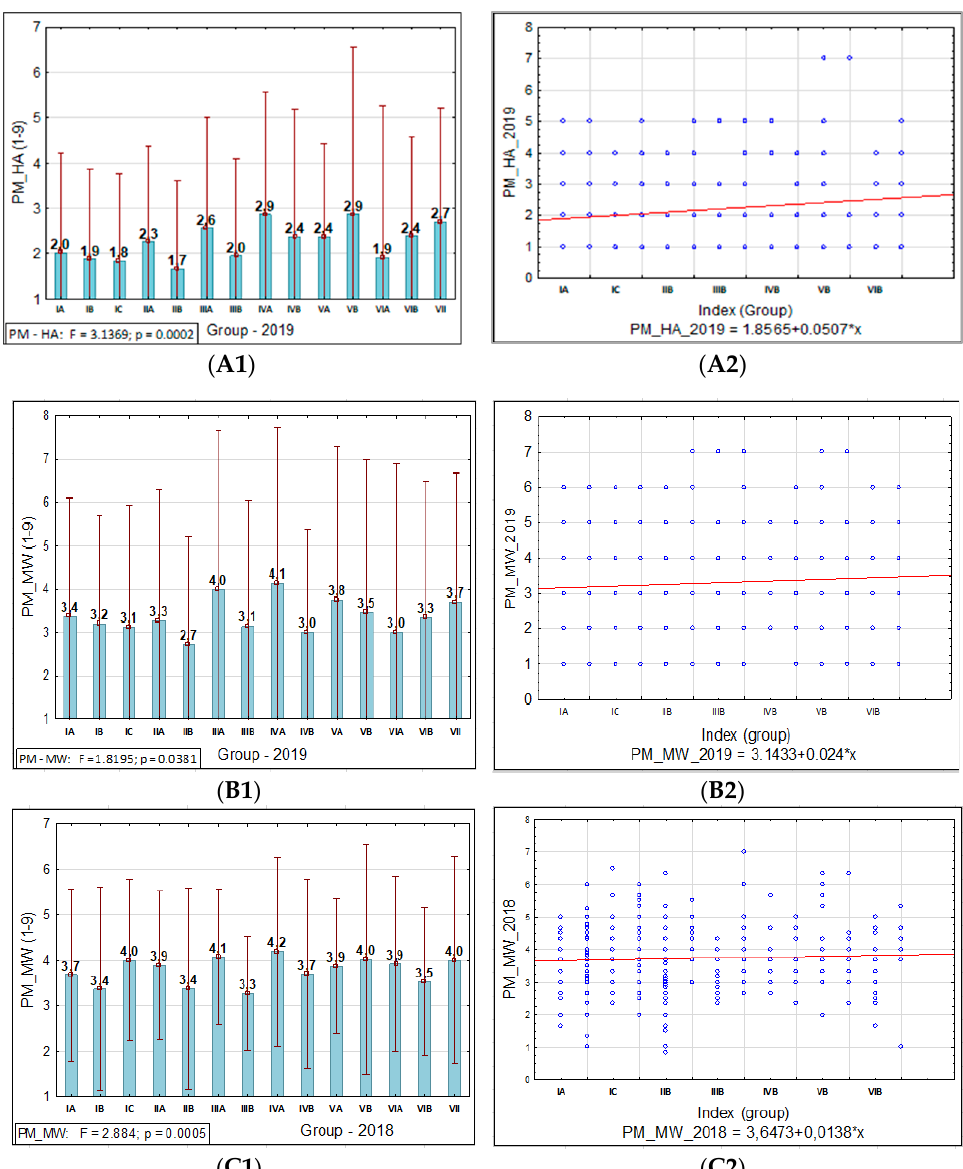
Figure 4. Powdery mildew (PM) resistance accessions belong to the sub-collections evaluated in 2018–2019 and their frequency distribution for the PM resistance scores. Figures ( A1 , B1, C1 ) present the results of the ANOVA ( p ≤ 0.05 ) and the bars represent the SD ( p ≤ 0.05 ). Figures ( B1 , B2,C2 ) present the regression analysis model estimating the relationship between the PM resistance scores and the frequency index. The sub-collections (groups) of accessions were created using two criteria: